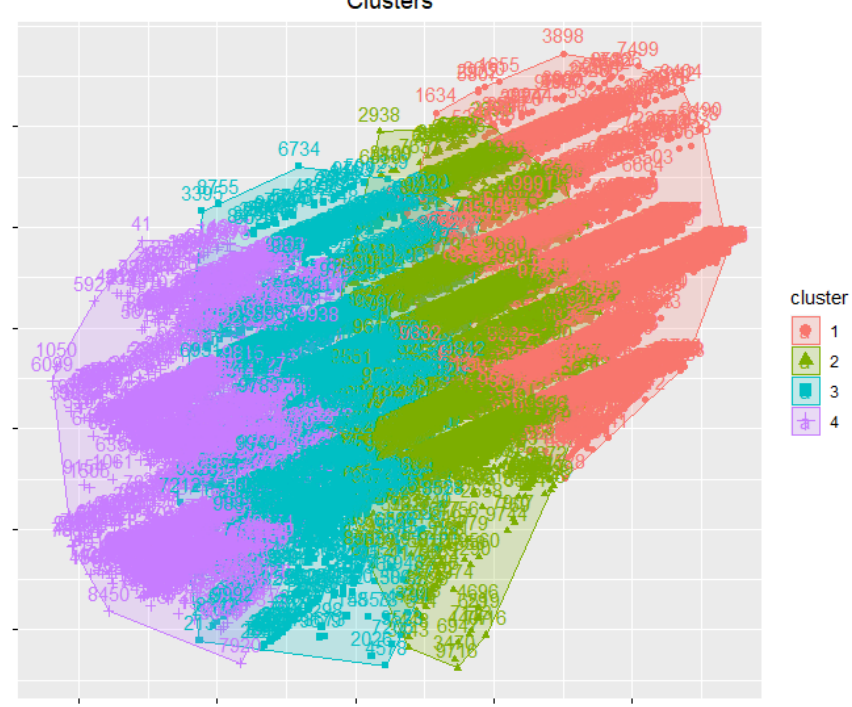
Figure 2. Density plot of observations projected onto the two-dimensional plane. Cluster 4 is the high death rate cluster. The axis values have been excluded, as they come from projecting categorical features coded as numeric onto the two-dimensional plane and do not have discernible biological